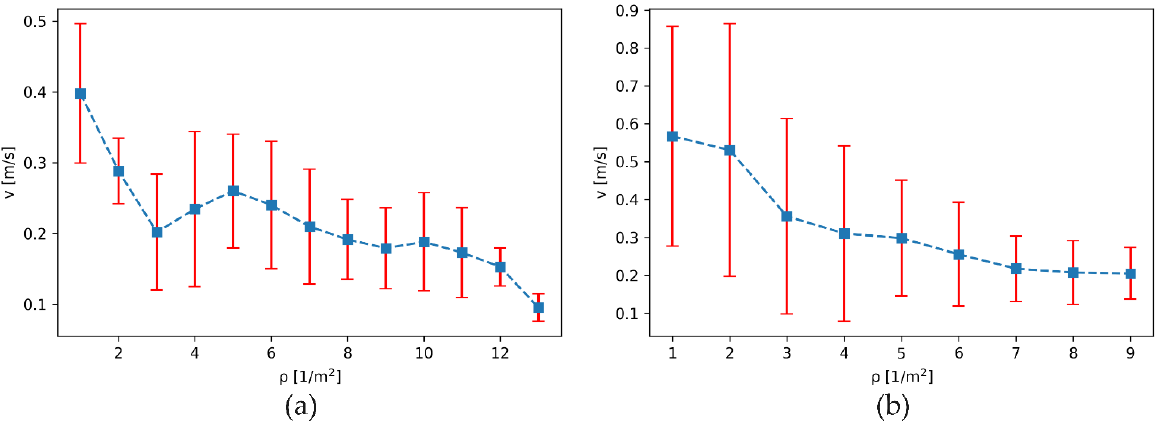
Figure 8. Fundamental diagrams. ( a ) Fundamental diagram generated by the real crowd experiment; ( b ) fundamental diagram generated by HDRLM3D.